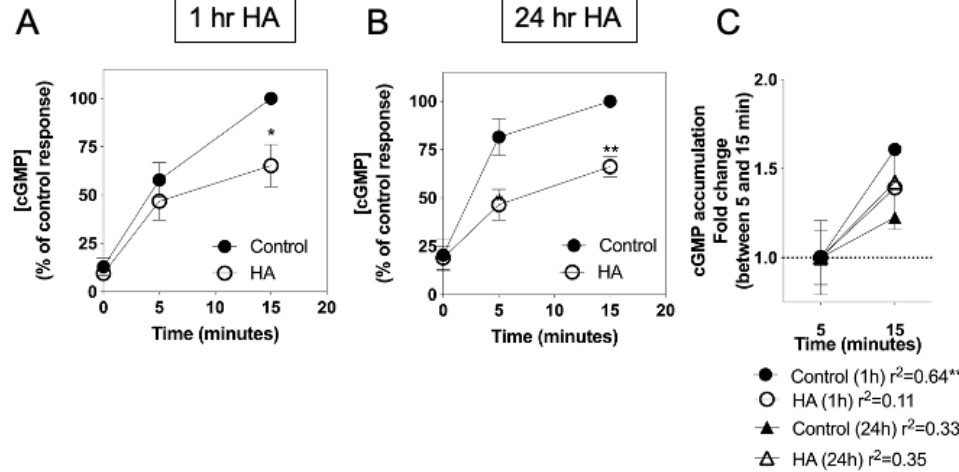
Figure 3. Effects of hyperammonaemia on CNP-stimulated cGMP accumulation in rat C6 glioma cells. Cells were initially treated in media containing 1% ( v / v ) FCS and 0 or 10 mM NH 4 Cl (HA) for either ( A ) 1 h or ( B ) 24 h, prior to subsequent stimulation with 100 nM CNP in the presence of 1 mM IBMX for up to 15 min. The data shown are means ± SEM of five to seven independent experiments, each performed in triplicate and are expressed as the percentage of the control; * p < 0.05, ** p < 0.01, significantly different from control response to CNP. ( C ) Linear accumulation of cGMP between 5 and 15 min of CNP stimulation. Data shown are normalized to cGMP accumulation after 5 min, expressed as means ± SEM of five to seven independent experiments. ** P < 0.01, significantly deviates from zero.